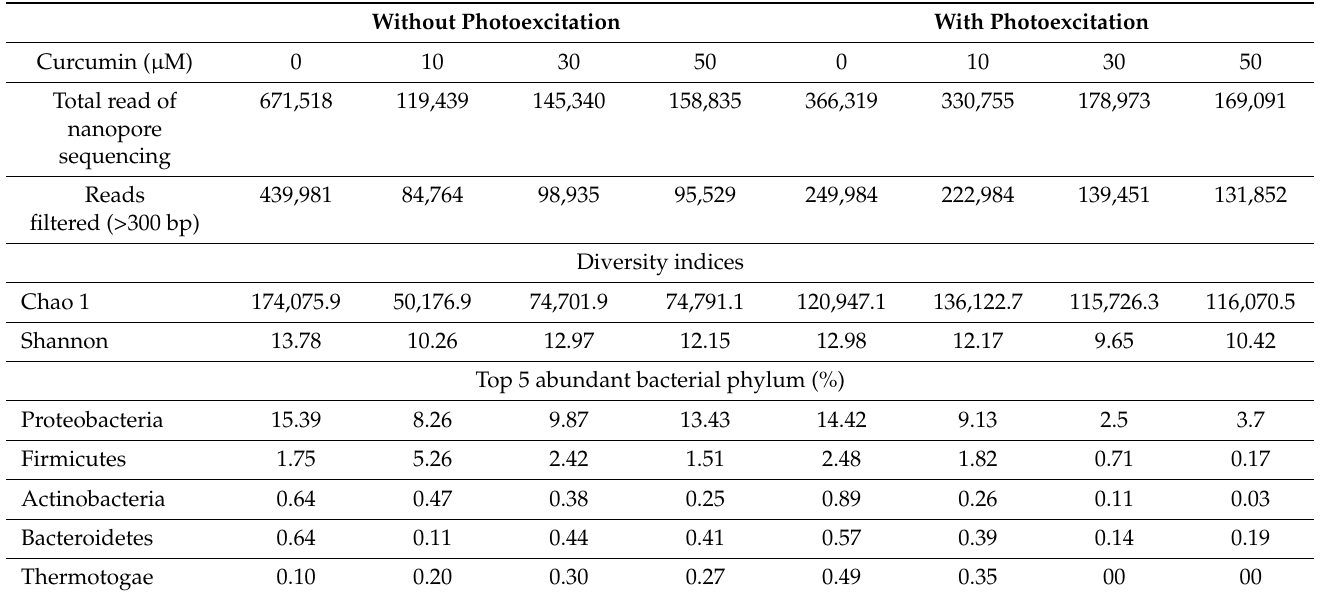
Table 2. Microbiome analysis of P. monodon exposed to different concentrations of curcumin in the presence and absence of